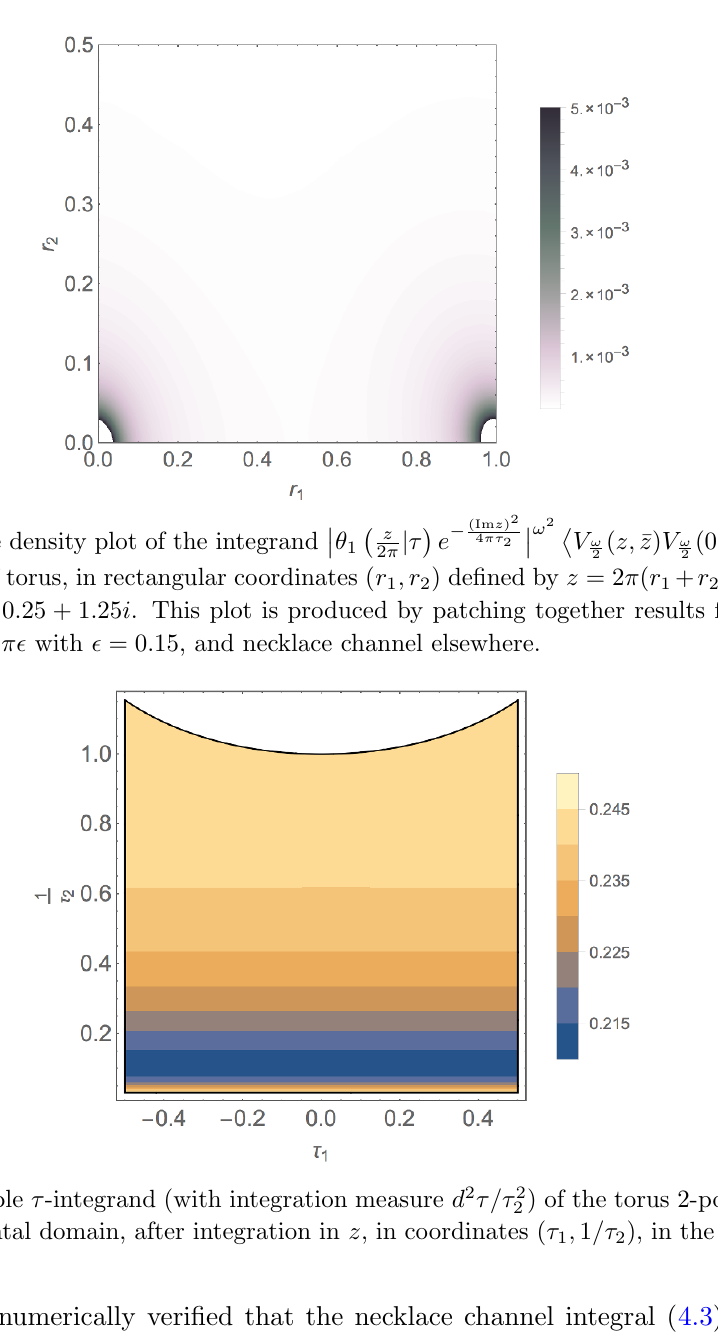
) of the torus 2-point amplitude 2